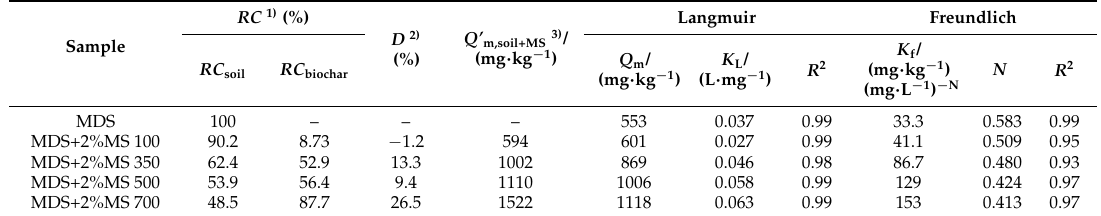
Table 6. The regression parameters of Langmuir and Freundlich model fittings for Cd adsorption isotherms and calculated values on the soil amended with biochar prepared at different temperatures.